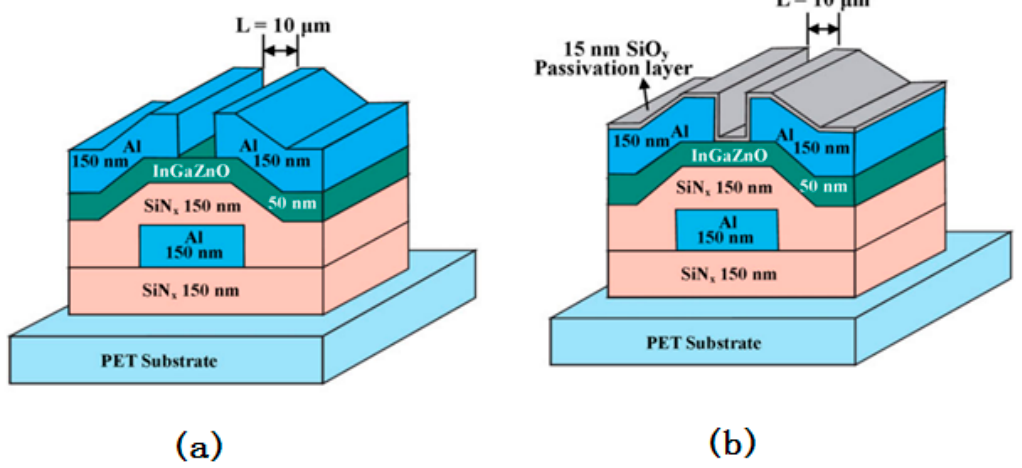
Figure 4. Schematics of bottom-gate-type indium gallium zinc oxide (IGZO) TFT [151], ( a ) un-passivated structure, ( b ) passivated structure.